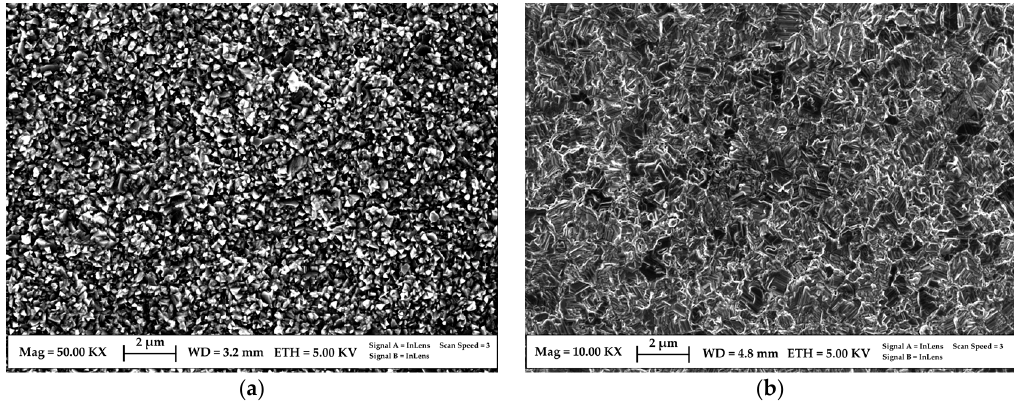
Figure 7. SEM images of the: ( a ) morphology of the as ‐ deposited InSe–GaSe–Cu precursor sequence; and ( b ) the resulting CIGS layer after selenization.